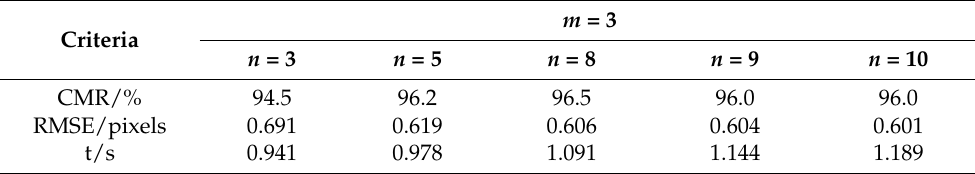
Table 6. The experimental results with a fixed m and different parameter settings of n .